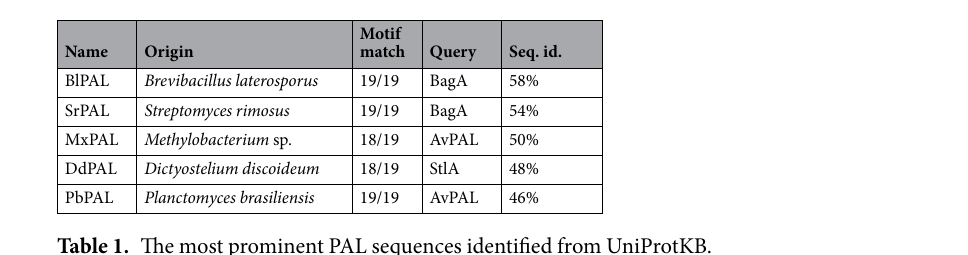
Table 1. The most prominent PAL sequences identified from